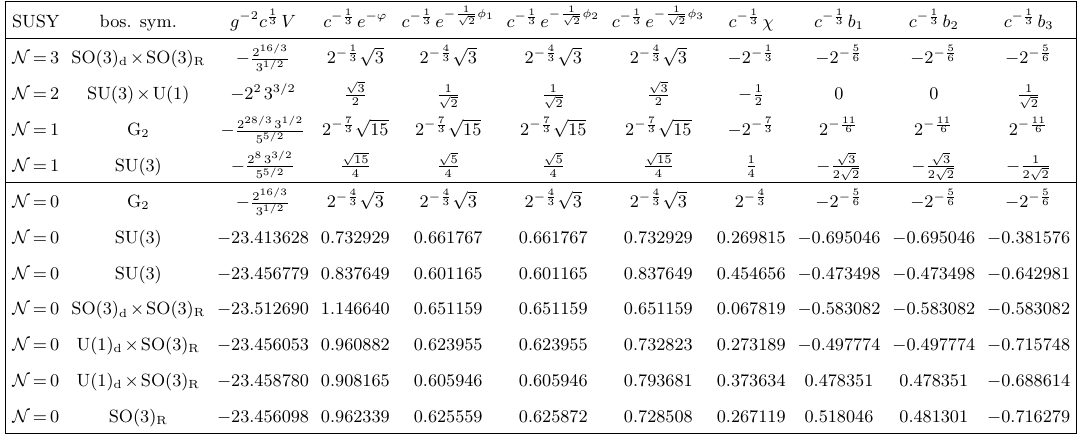
Table 3. D = 4 scalar vevs on the AdS 4 (cid:2) S 6 type IIA backgrounds of section